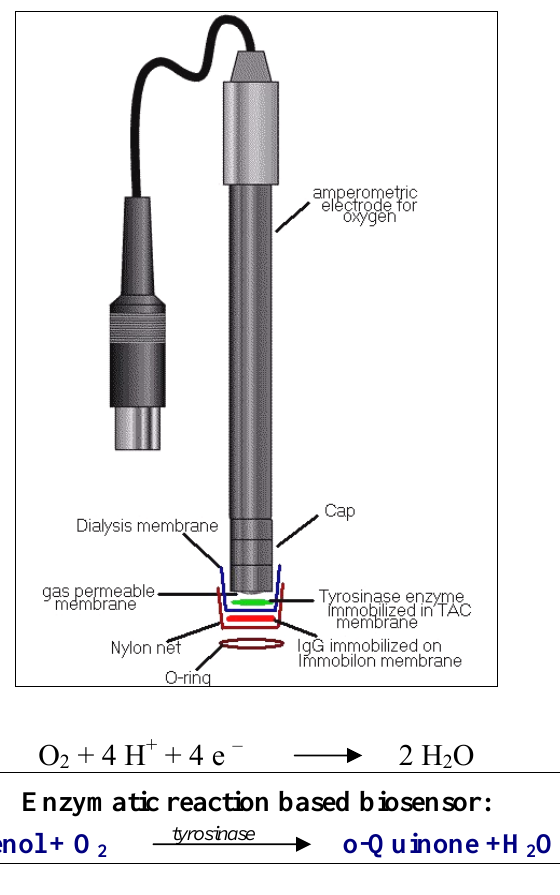
Figure 5. Immunosensor for IgG